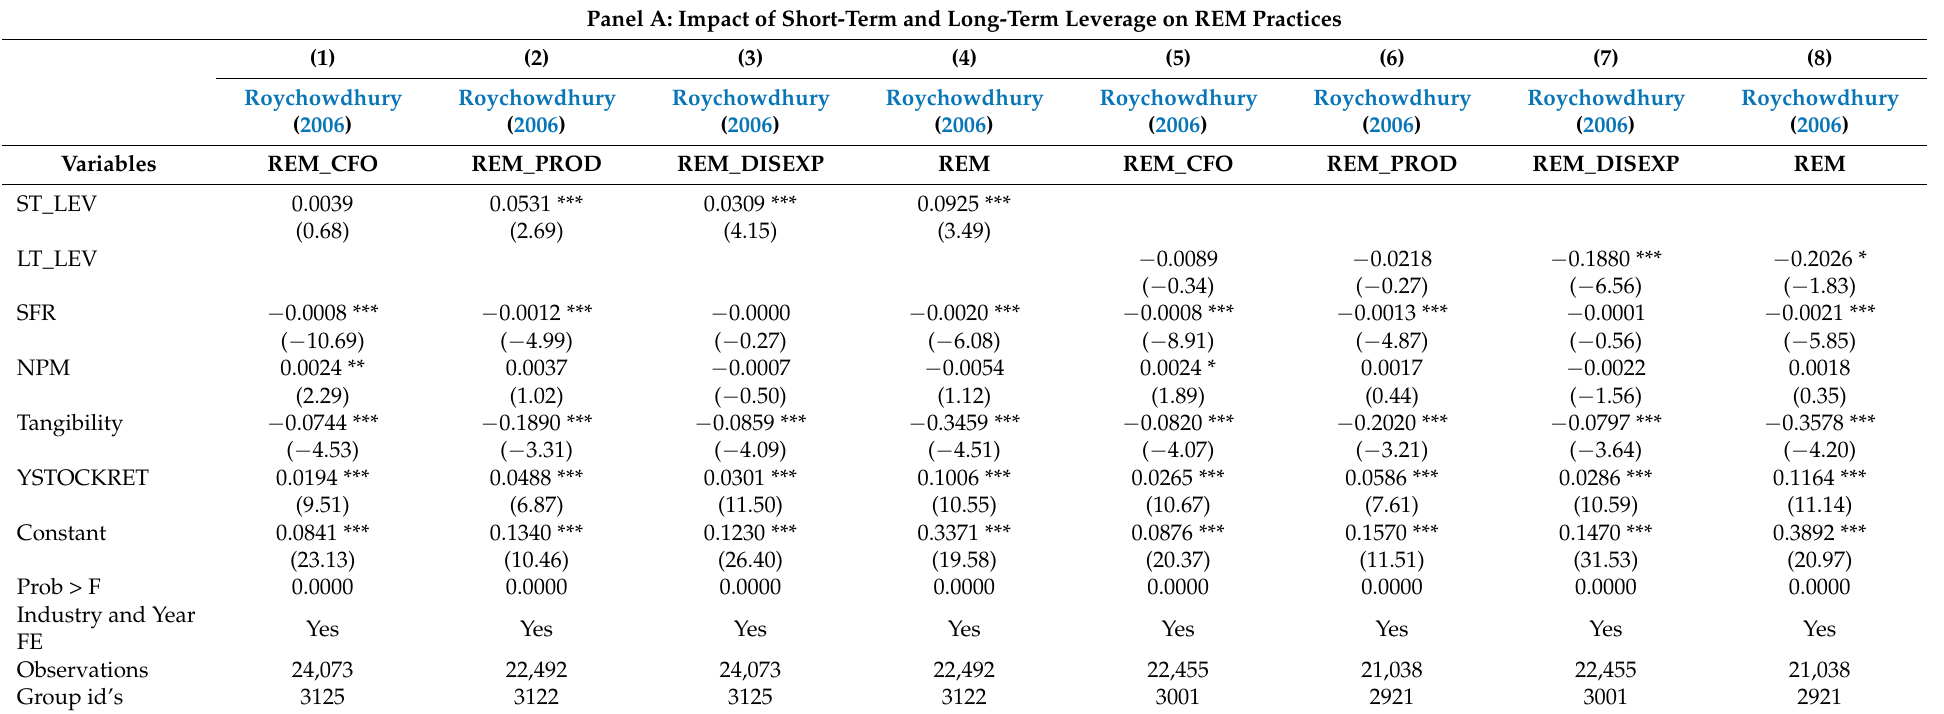
Table 4 report the results of the impacts of short-term and long-term leverage (ST_LEV and LT_LEV, respectively) on REM practices in context of panel A (all Chinese non-financial listed firms). t-statistics are informed in parentheses. ***, ** and * indicates the p < 0.01, p < 0.05, and p < 0.1,